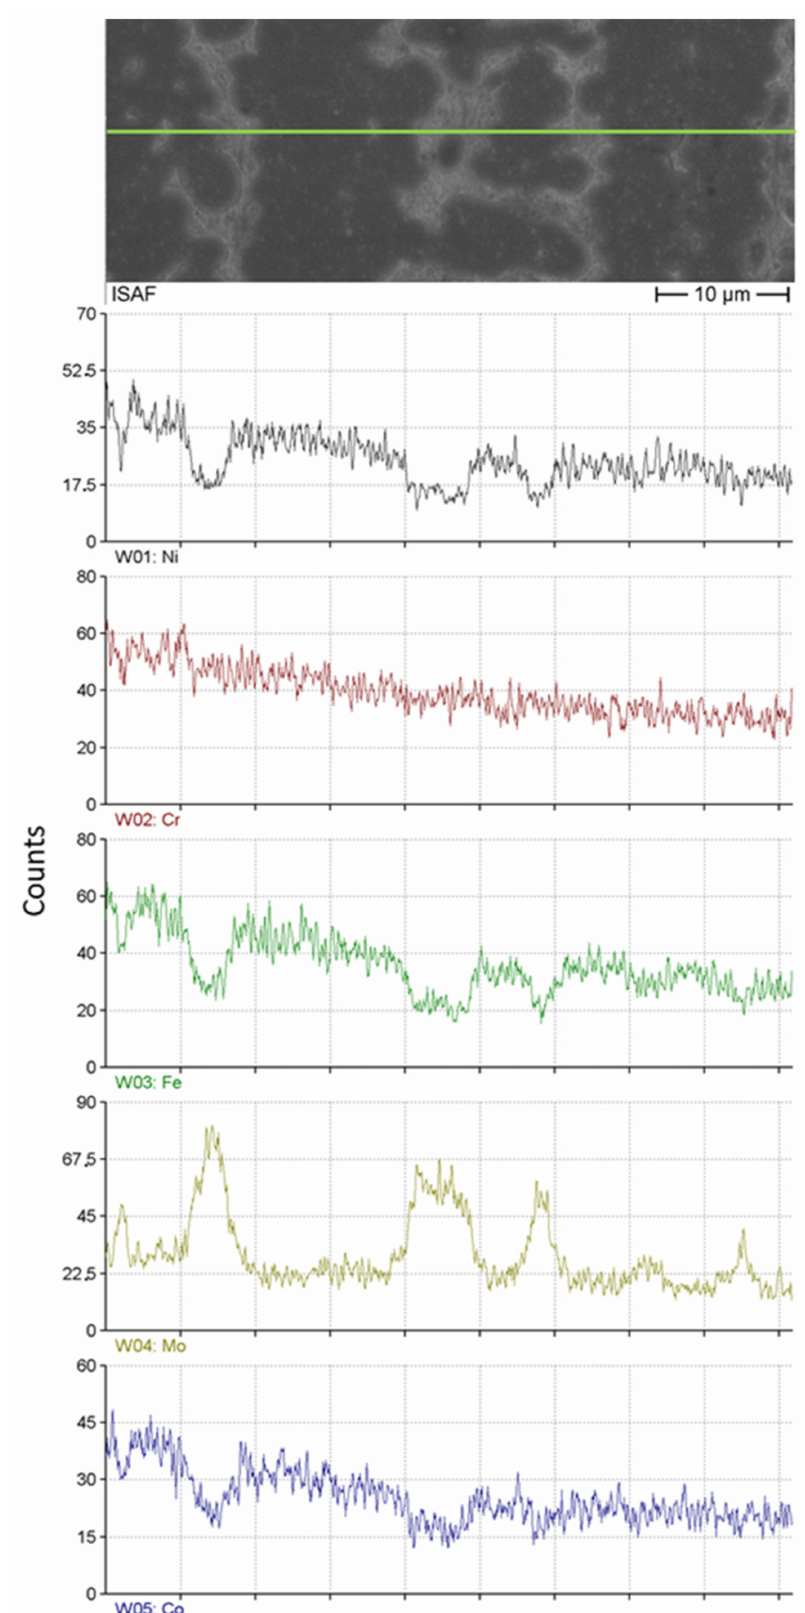
Figure 9. SEM image of the microstructure and counts from a performed EDX line